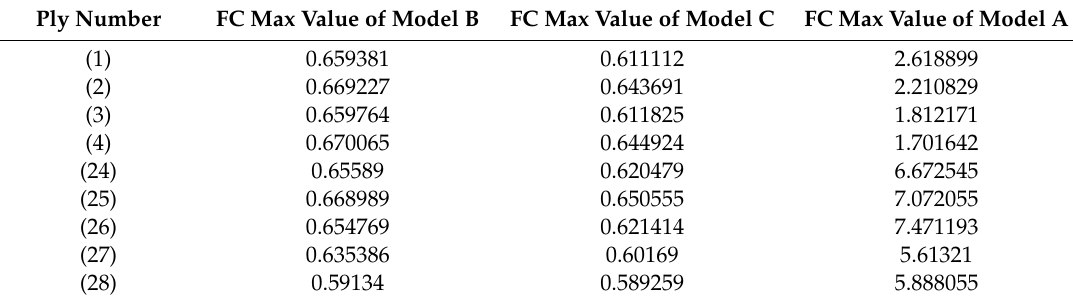
Table 4. Failure indexes for 1–4 and 24–28 plies.